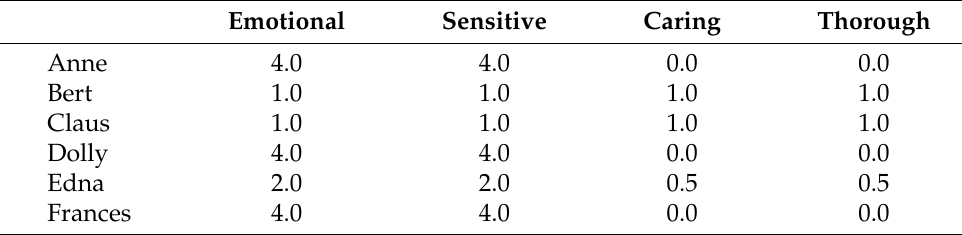
Table 3. Matrix of situation 3: “family picnic” for behavioral level data.